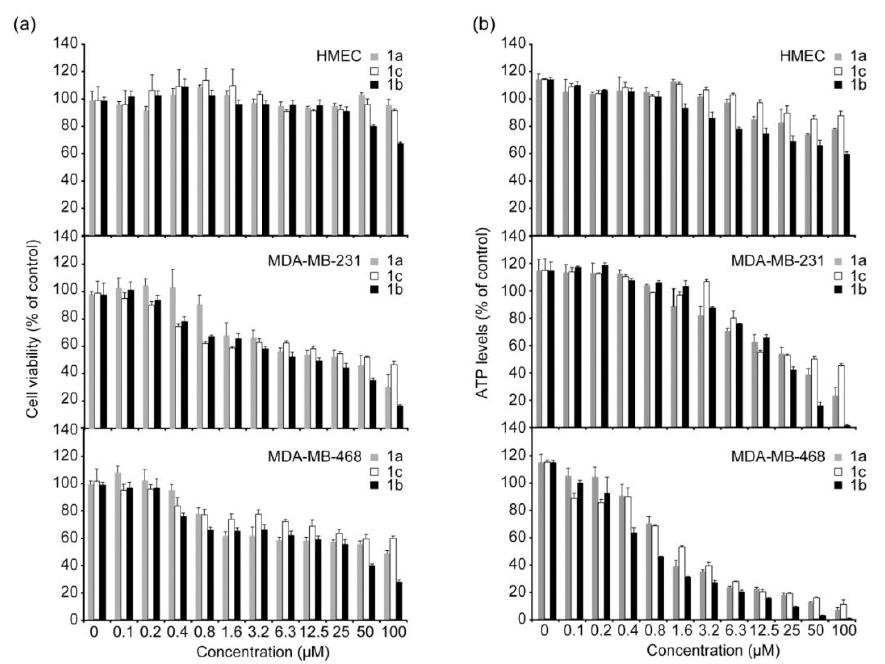
Figure 24. (Panel a ) Cell growth measured 24 h after treatment with 6a , 6b , and 6c . (Panel b ) ATP levels of cells measured 24 h after treatment, using the ATPlite luminescence assay kit. (Reprinted with permission from ref. [99]. Copyright 2008 American Chemical Society).